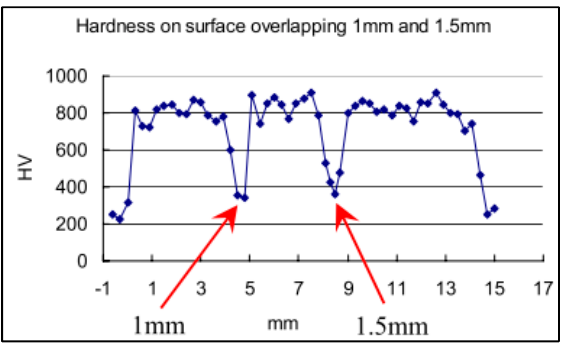
Figure 4. Microhardness profile as a function of overlapping size (Reprinted with permission from ref. [41]. 2010 Elsevier).